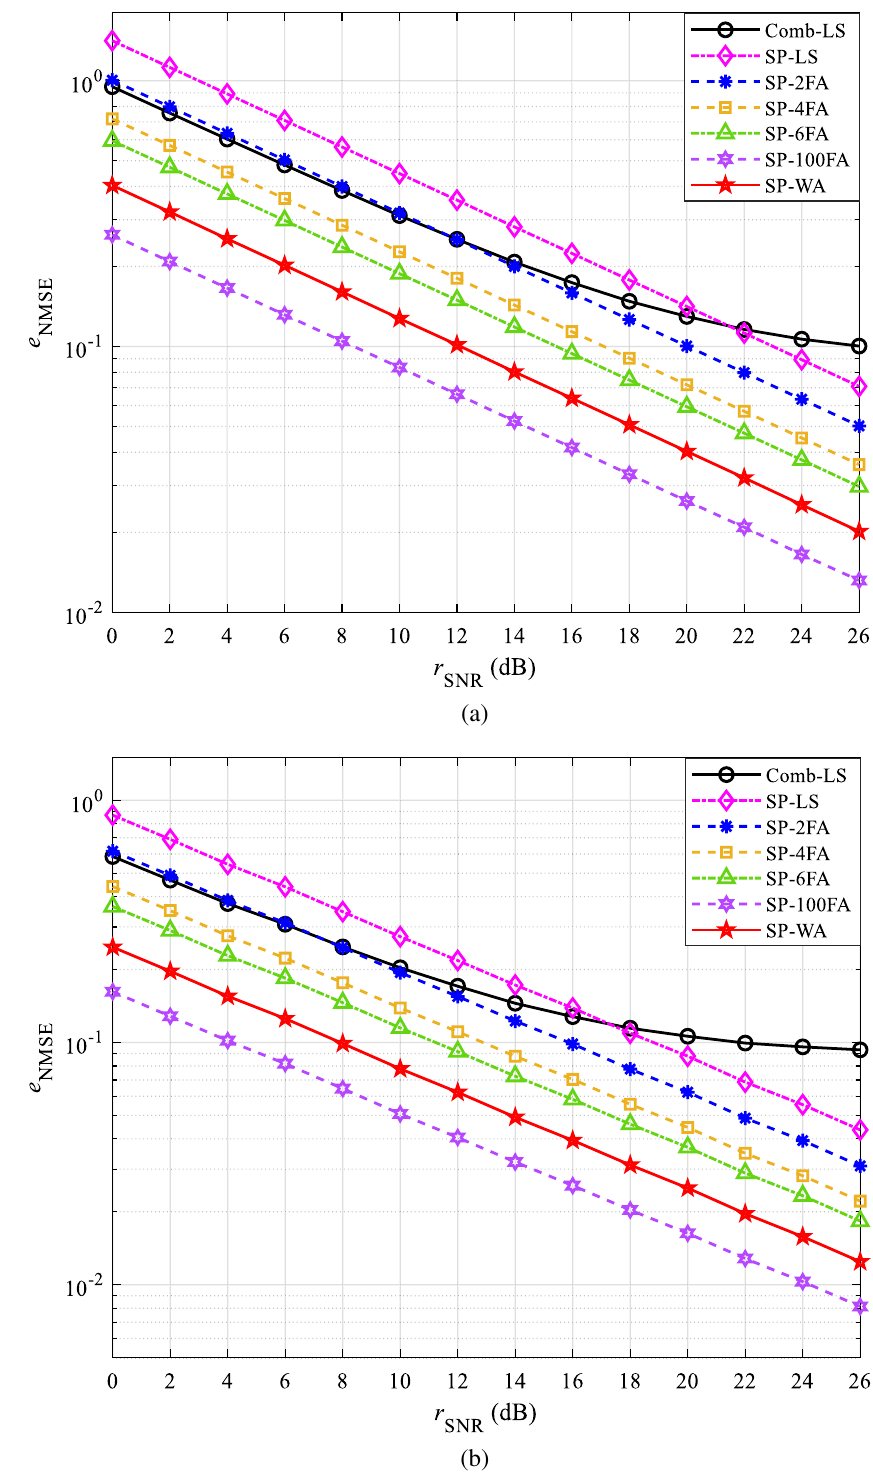
Figure 6. The NMSE performance in CDT 6 channel: ( a ) QPSK and ( b )